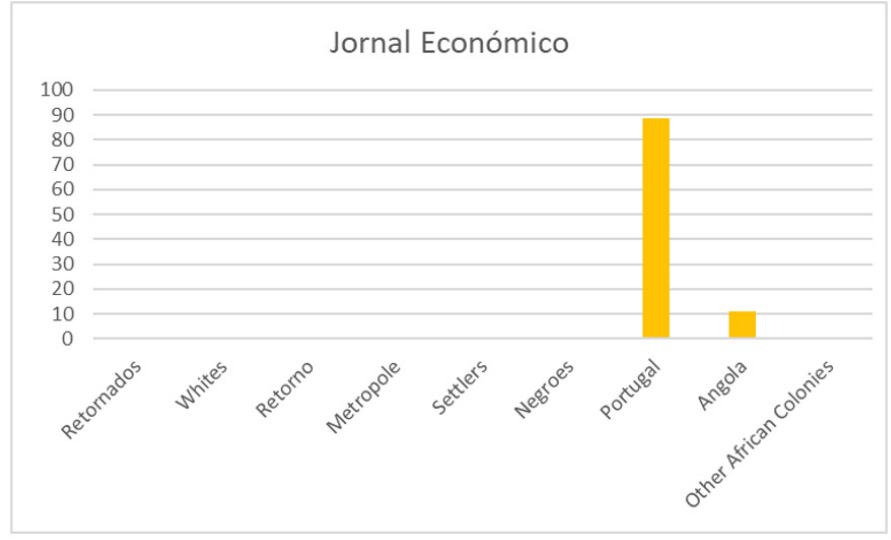
Figure 14. Most frequent words in the text “Os Combatentes do Ultramar”. Source: Jornal Económico (2021) [27].